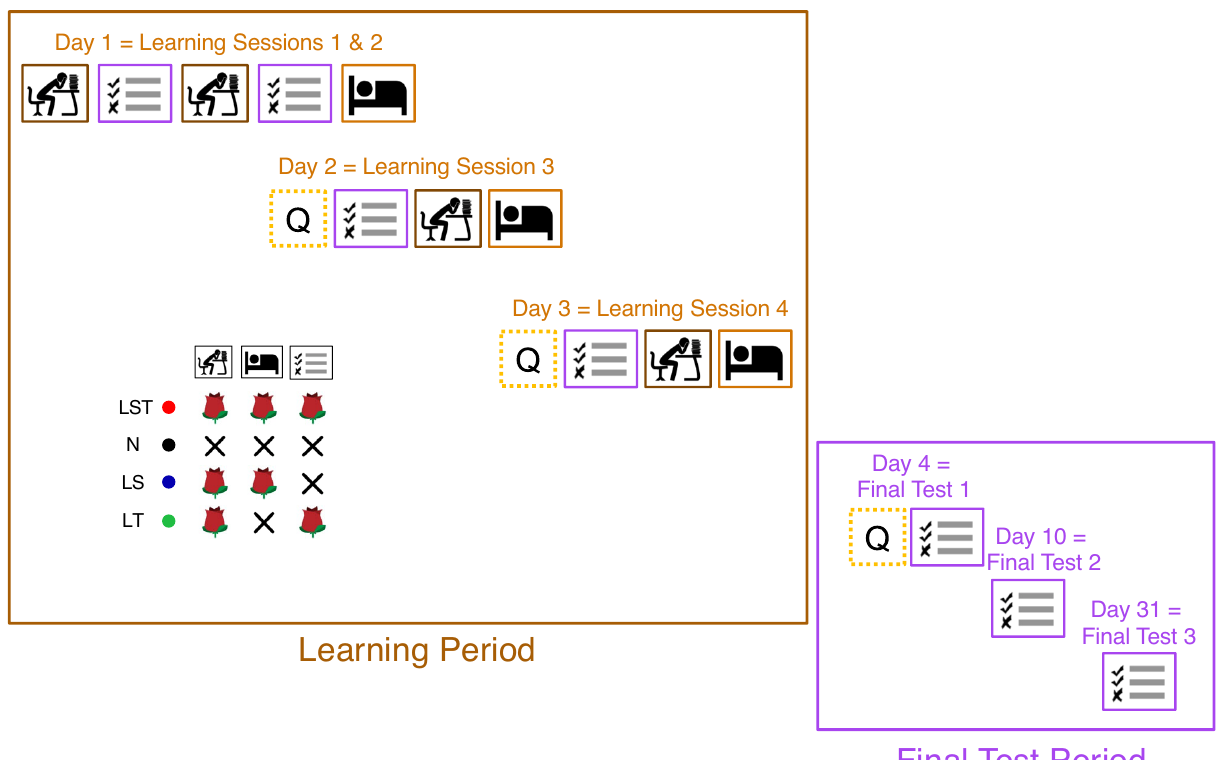
Figure 1. Experimental setup. Day 1 consisted of 2 Leaning Sessions, with one Learning Session consisting of a learning part which was followed by a testing part. Day 2, 3 and 4 started with the SFA questionnaire (Q). On day 2 and 3, the questionnaire was followed by the Learning Session, which started with the testing part and was followed by the learning part (order is switched compared to day 1). On day 4 the Final Test period started after the questionnaire with the first Final Test. Participants conducted Final Tests on day 4, day 10 and on day 31. The table with pictograms on the bottom left summarizes the four experimental conditions. The icons therein are adopted from Neumann et al.